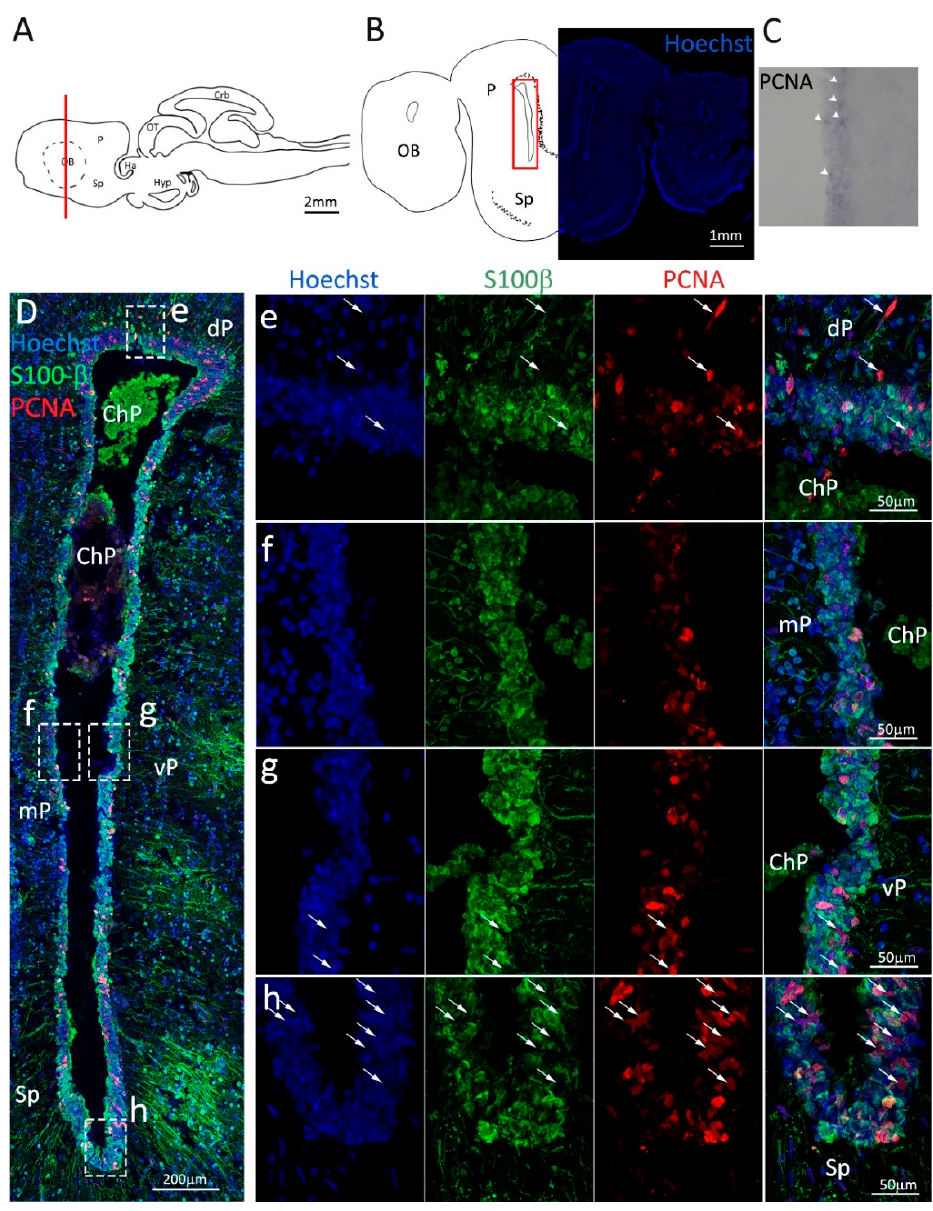
Figure 1. Localization of PCNA and S100 β positive cells in the anterior telencephalon of S. canicula . ( A ) Sagittal representation of S. canicula brain. The red line indicates the rostro-caudal localization of the section represented in the panel. ( B ) Coronal map of the anterior telencephalon. On the right, a real coronal section is stained with Hoechst 33342 to show nuclei distribution; on the left, a cartoon is drawn to indicate anatomical references. Red rectangle identifies the general area from which images are taken. ( C ) S. canicula PCNA in situ hybridization in the anterior telencephalon ventricle. White arrowheads indicate cells expressing pcna mRNA. ( D ) Anterior telencephalic neurogenic niche. Radial glial cell bodies (S100 β + , green) are localized around the ventricular wall and their processes spread into the surrounding tissue. Some S100 β + cells are also PCNA + (red), indicating the proliferative state of the stem cells. ( e ) Magnification of the neurogenic niche localized in the dP. White arrows indicate PCNA + / S100 β − cells. ( f ) Magnification of the neurogenic niche localized in the mP. ( g ) Magnification of the neurogenic niche localized in the vP. White arrowheads indicate PCNA + /S100 β − cells. ( h ) Magnification of the neurogenic niche localized in the Sp. White arrowheads indicate PCNA + /S100 β − cells. Abbreviations: OB: olfactory bulb, P: pallium, Sp: subpallium, dP: dorsal pallium, mP: medial pallium, vP: ventral pallium, ChP: choroid plexus. Costaining of Msi1 and PCNA (Figure 2c–f, green and red, respectively) confirmed the localization of the progenitor cells tightly packed around the ventricle walls. On the